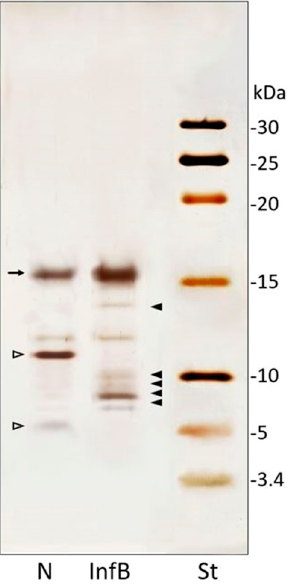
Figure 2. Tricine-SDS-PAGE (16%) of hemolymph samples. Patterns of low molecular weight proteins (<30 kDa) of hemolymph from naïve (N) and E. coli/M. luteus- infected (InfB) larvae; standard molecular weights marker (St). Full arrowheads indicate newly synthesized bands and the arrow an increased band, observed after bacterial infection. Empty arrowheads indicated disappeared peptides after bacterial infection.